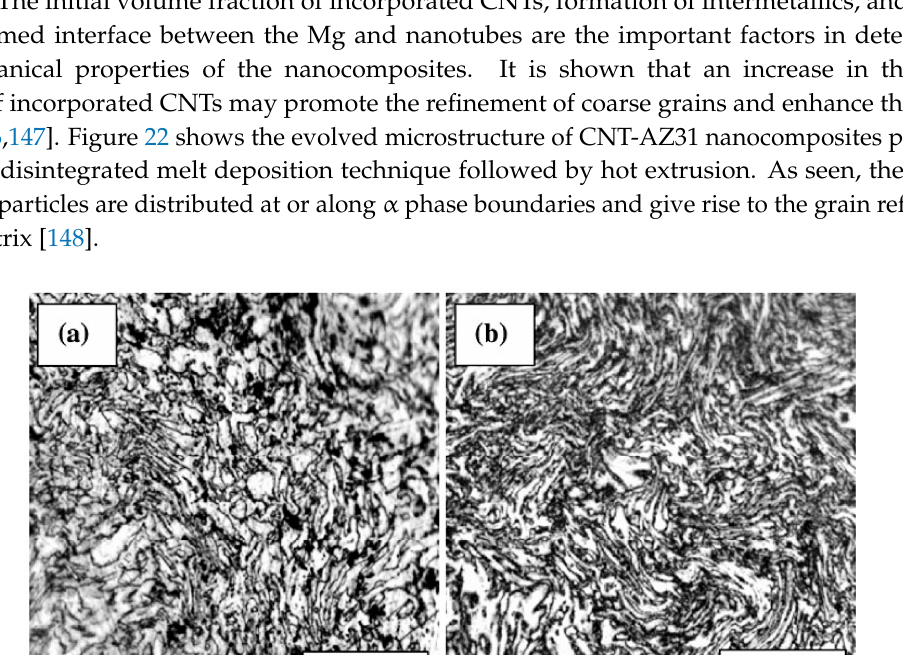
Figure 23. A schematic view of Mg 17 Al 12 particles formed in Mg-3Al-1Zn/MWNTs nanocomposites prepared by powder metallurgy method. The incorporation of MWNTs can drastically refine the particles ( β phase corresponds to Mg 17 Al 12 ) [146]. (Reproduced with permission from [146], Elsevier, 2015.) A review on the literature confirms that recent research works have strived to attribute the enhanced properties of CNT-Mg composites to the formation of different intermetallics. Fukuda et al. [144] have resorted to Al 2 MgC 2 compound. However, an opposite trend has been observed by Pei et al. [110], where Al 2 MgC 2 strengthens the carbon nanofiber/Mg interface, but simultaneously leads to decreased mechanical properties. It is ascribed to the difference in the extent of graphitization. In other words, produced Al 2 MgC 2 intermetallic in CNT-reinforced composites insignificantly affects the CNTs strength. Table 4 provides the readers with an overview of the fabrication method, chemical composition of the possible intermetallic compounds, and variations in mechanical properties of the composites.